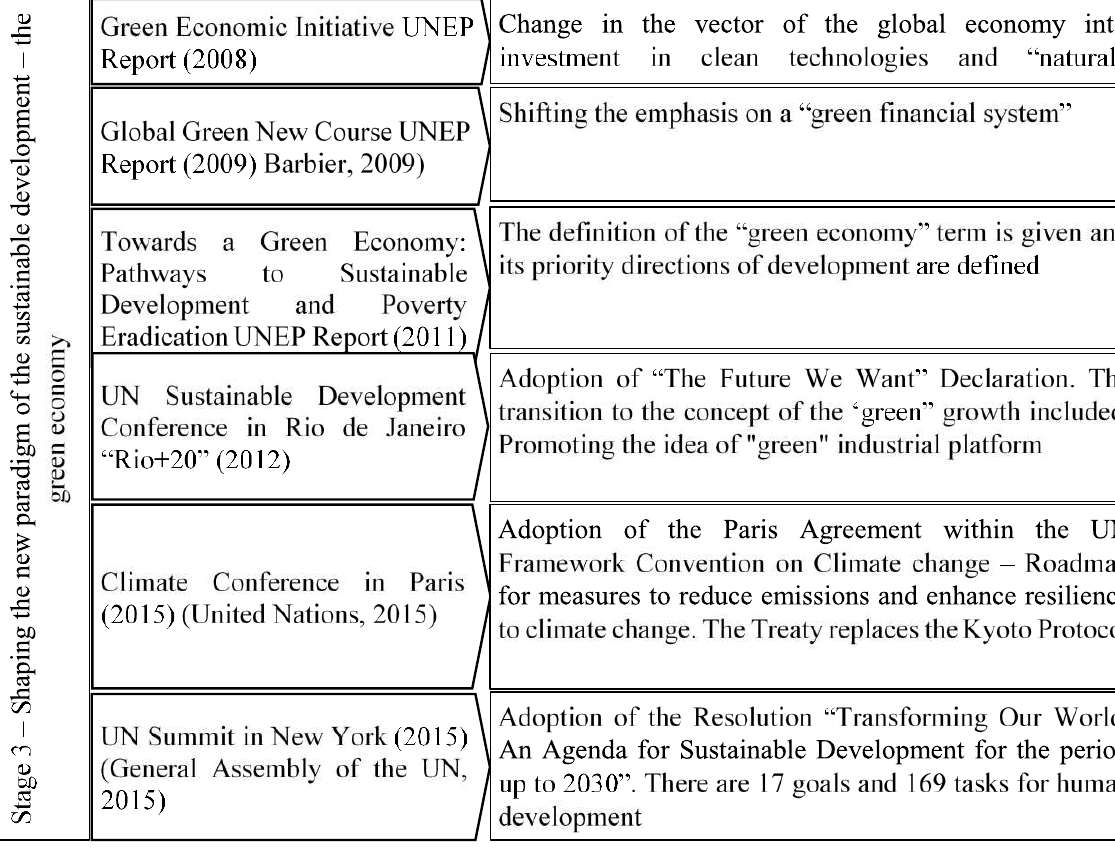
Fig. 3. Shaping the new paradigm of the sustainable development – the green economy (the third stage – from 2007 to